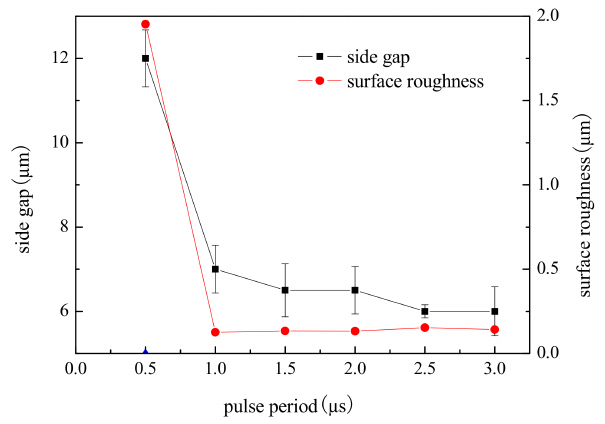
Figure 9. Effect of pulse period on side gap and surface roughness.